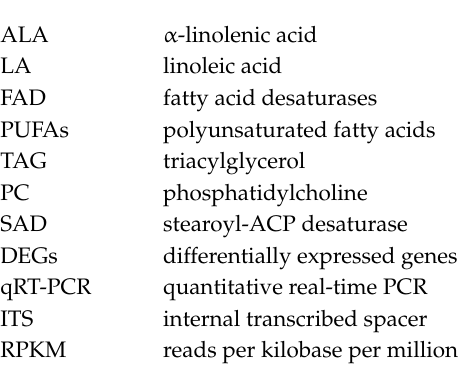
for sequences from two Paeonia species. Figure S3. Comparative distribution of GO terms between the two Paeonia species. Figure S4. Comparison of relative transcript levels for 10 genes by qRT-PCR and RNA-seq. Figure S5. Correlation analysis between qRT-PCR and RNA-seq data. Table S1. Summary of reference seed transcriptome assembly and annotation. Table S2. Summary of major lipid pathways with unigenes and total expression levels. Table S3. The expression (RPKM values) of lipid metabolism genes in seeds of the two Paeonia species. Table S4. Annotation and transcript levels for select genes associated with lipid metabolism in seeds plastid and endoplasmic reticulum. Table S5. Primers used in this study. Table S6. Species used in phylogenetic